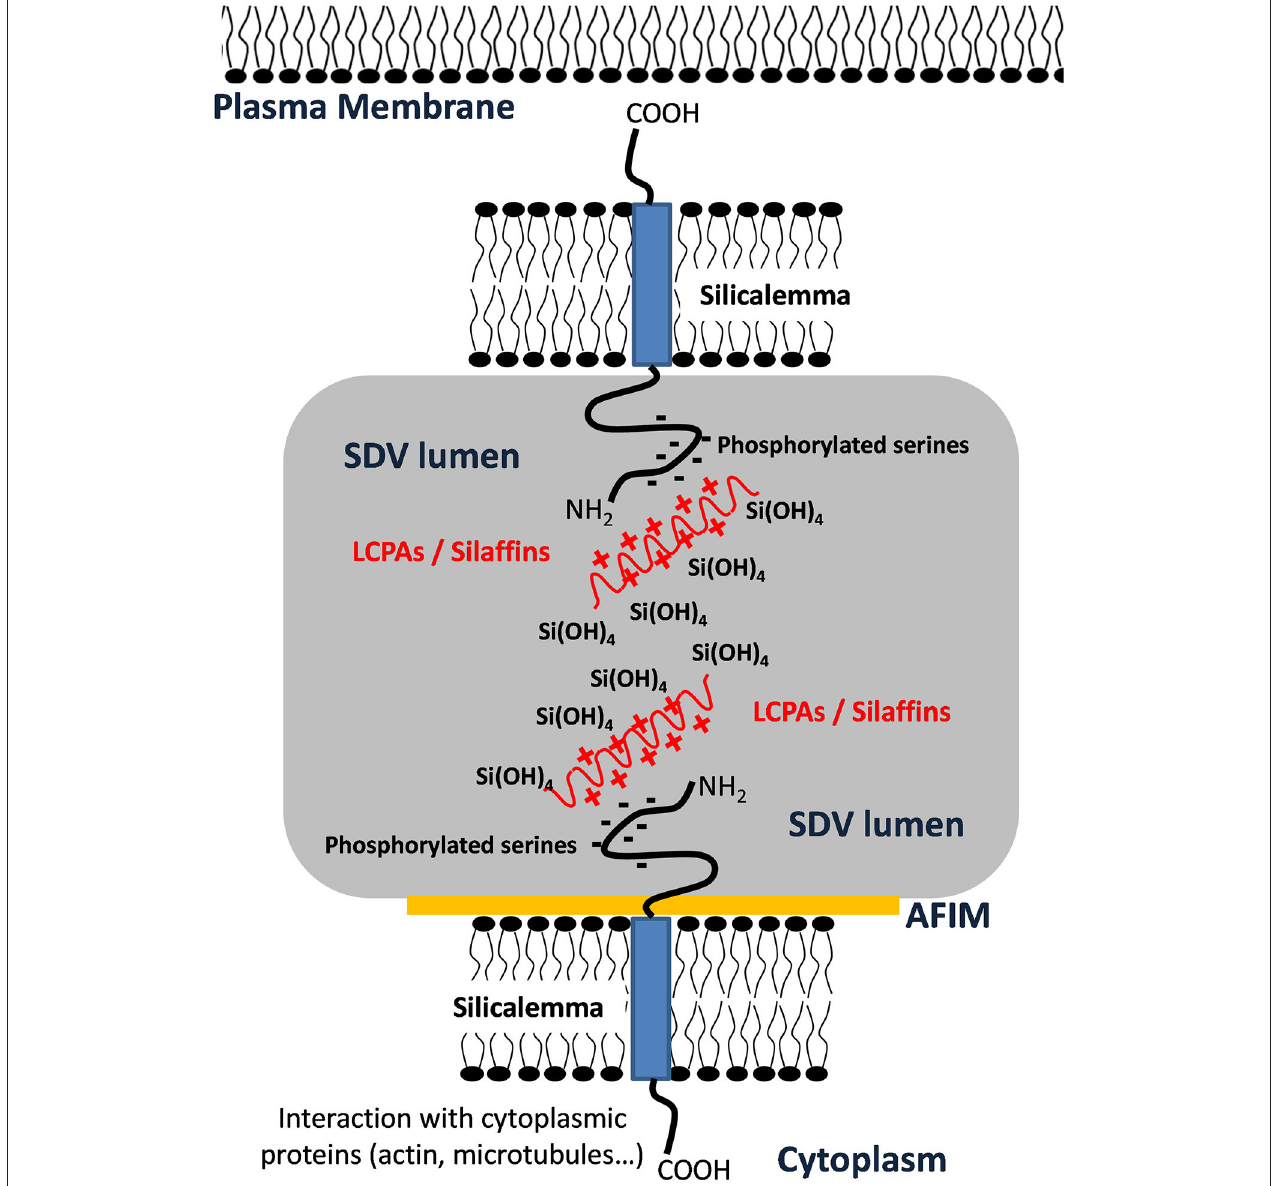
FIGURE 6 | Schematic representation of transmembrane protein organization into the SDV membrane showing putative interactions of phosphorylated serine with Long Chain Polyamines (LCPAs) or silaffins inside the SDV lumen and interaction with cytoplasmic proteins via the cytoplasmic domain. This figure was modified from Tesson et al. (2017) and is based on a model by Robinson and Sullivan